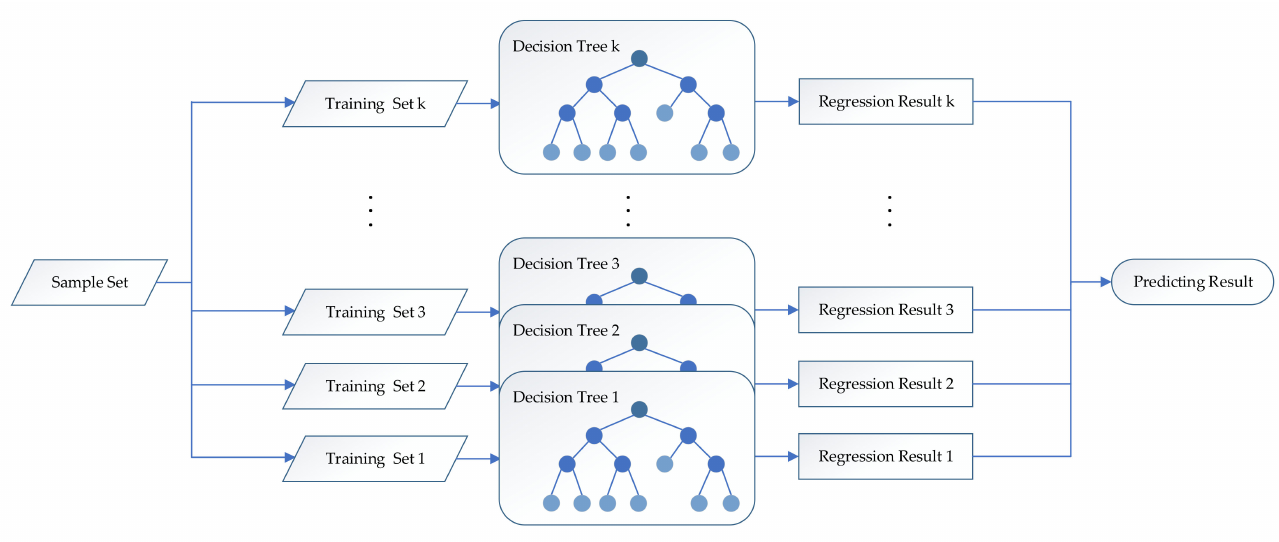
Figure 2. Random forest regression algorithm